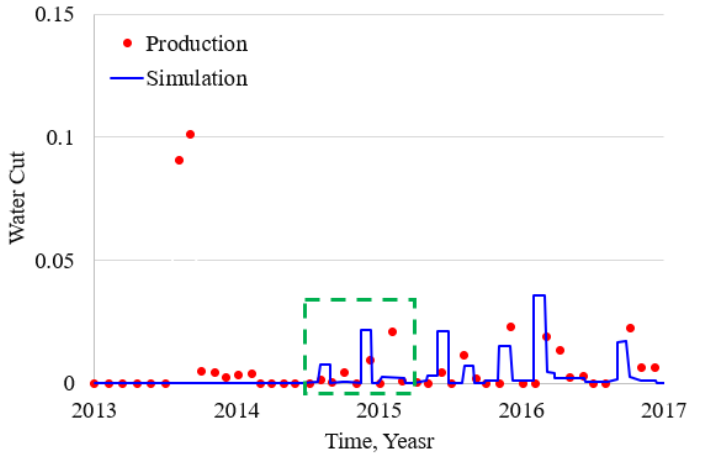
Figure 16. Results of production and numerical simulation.